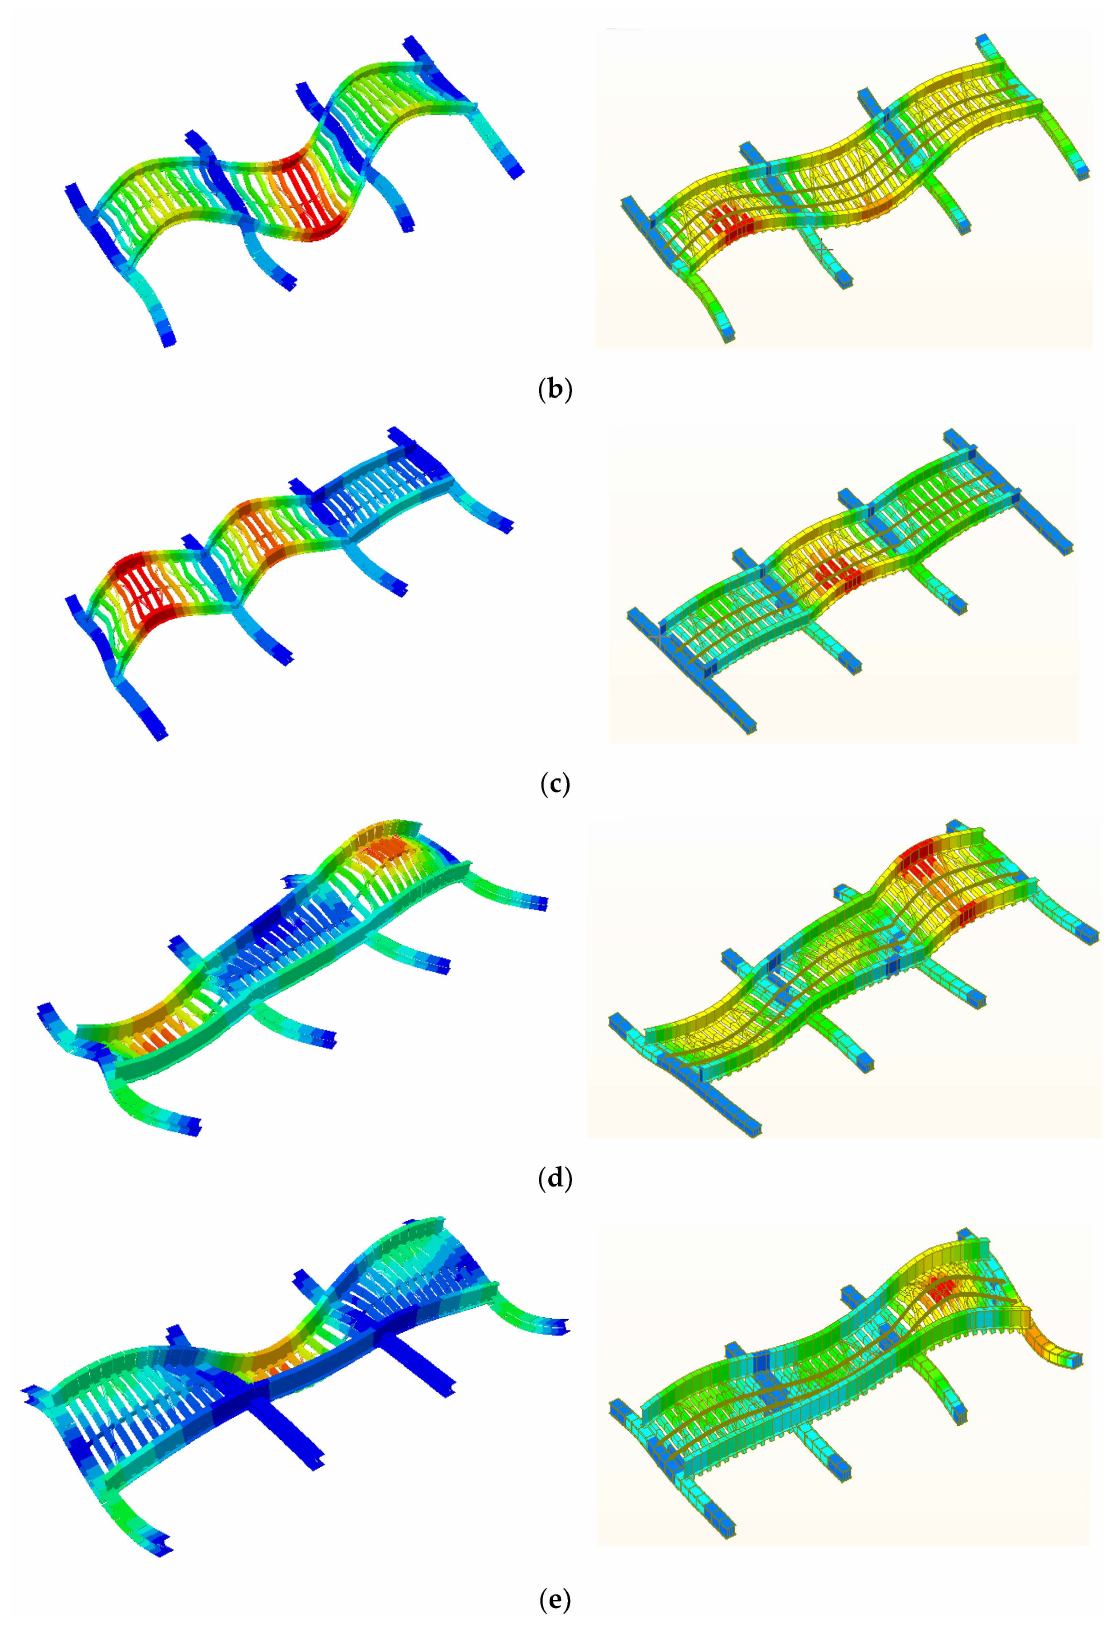
Figure 6. Comparison of vibration modes calculated by ABAQUS and Midas: ( a ) First order mode. ( b ) Second order mode. ( c ) Three order mode. ( d ) Four order mode. ( e ) Five order